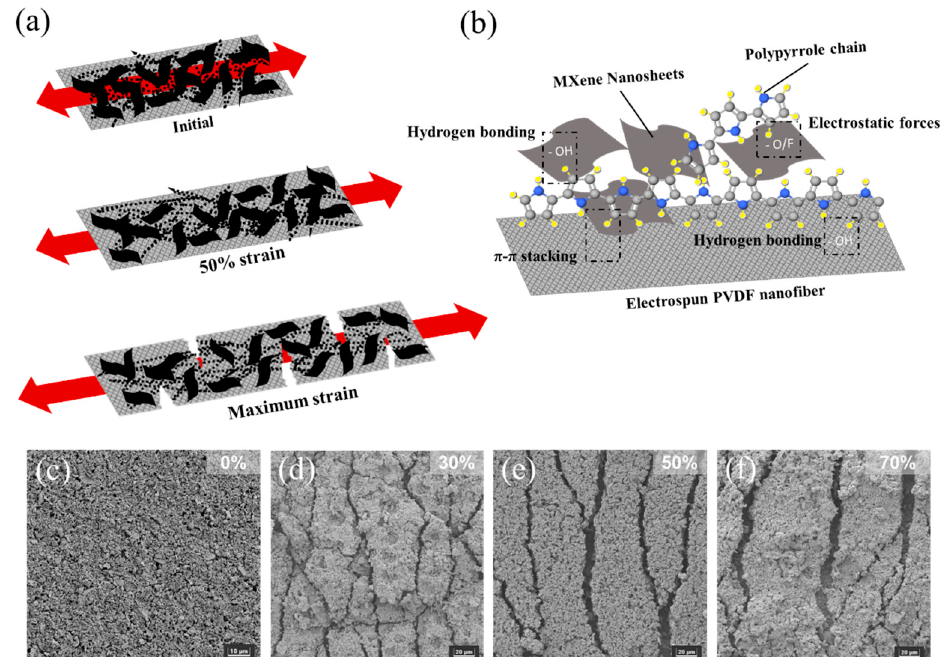
Figure 4. ( a ) Proposed sensing mechanism of Mxene/PPy electrospun PVDF sensor. ( b ) Illustration of chemical structure and interaction of MXene/PPy blending into the PVDF matrix to form an H-bonding. Morphology of the Ti 3 C 2 T x /PPy 0.4 /PVDF under tensile strain of ( c ) 0% ( d ) 30% ( e ) 50% ( f ) 70%.